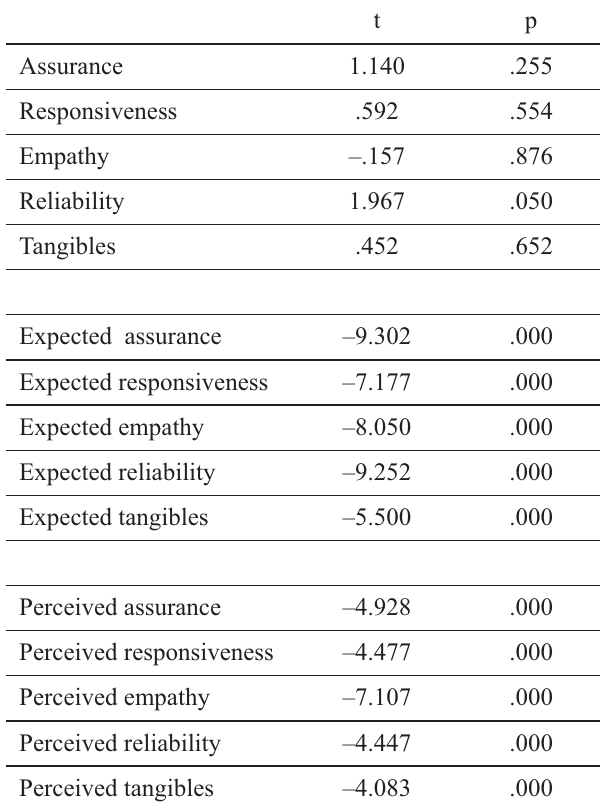
Table 5. Independent samples of T-tests for the fi ve